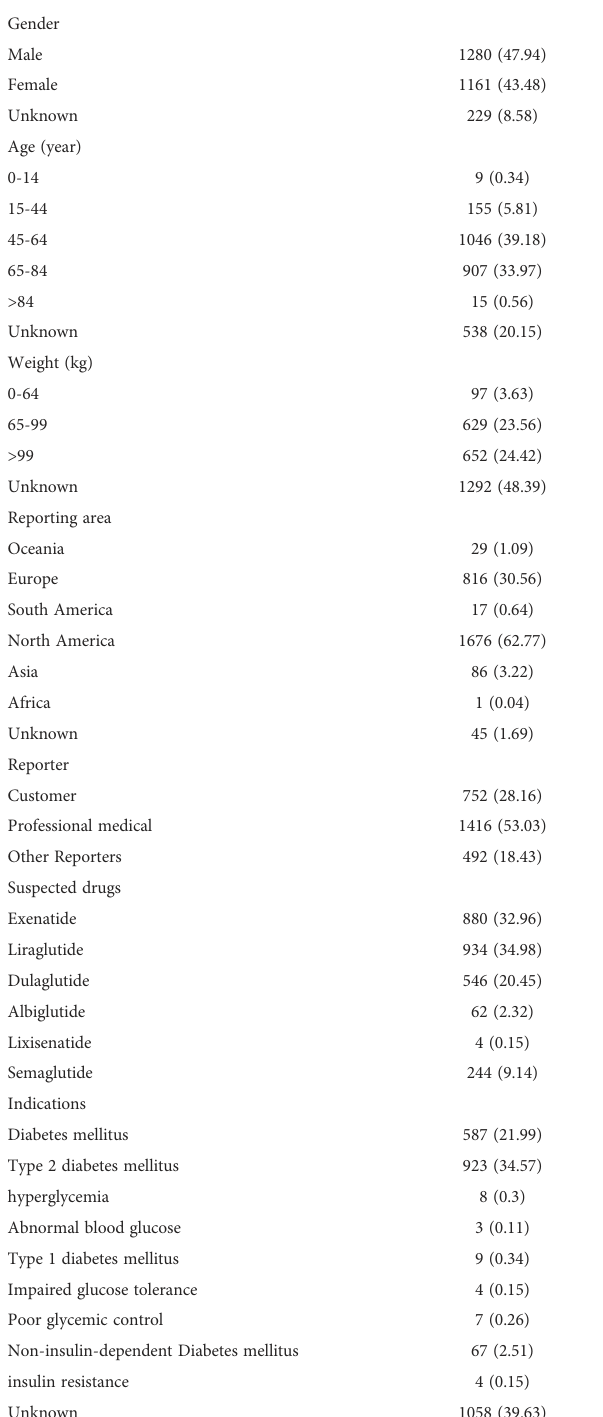
TABLE 3 The speci fi c clinical characteristics of GLP-1RA induced acute renal injury were excavated from FAERS.